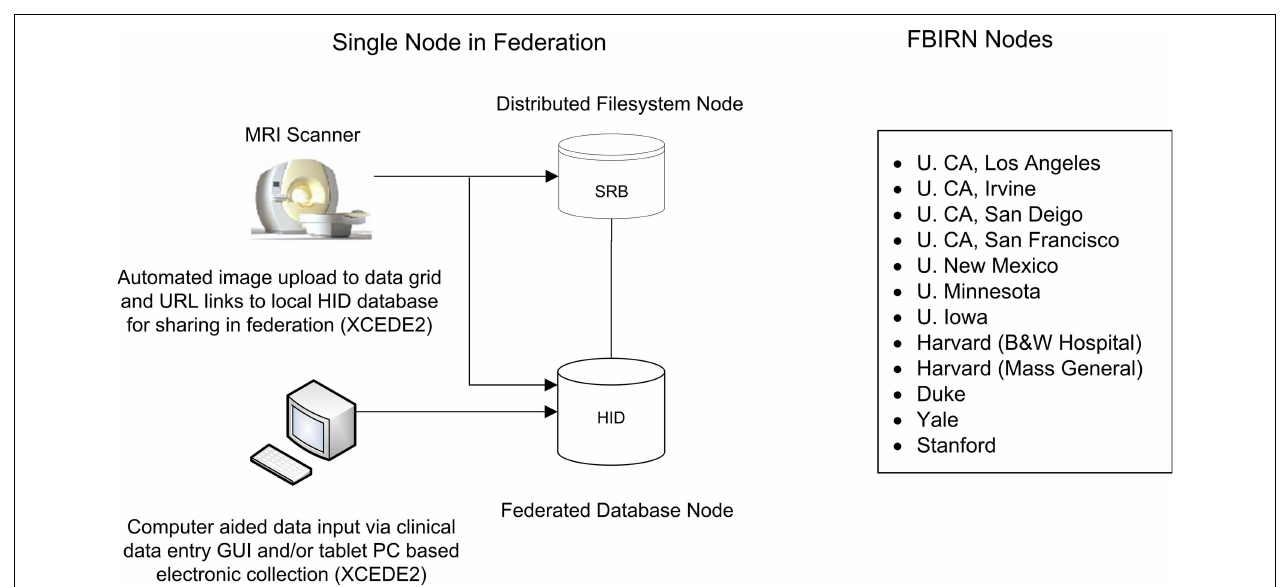
FIGURE 1 | Schematic of original (raw) data entry and fi le registration process at a node in the federation and FBIRN node